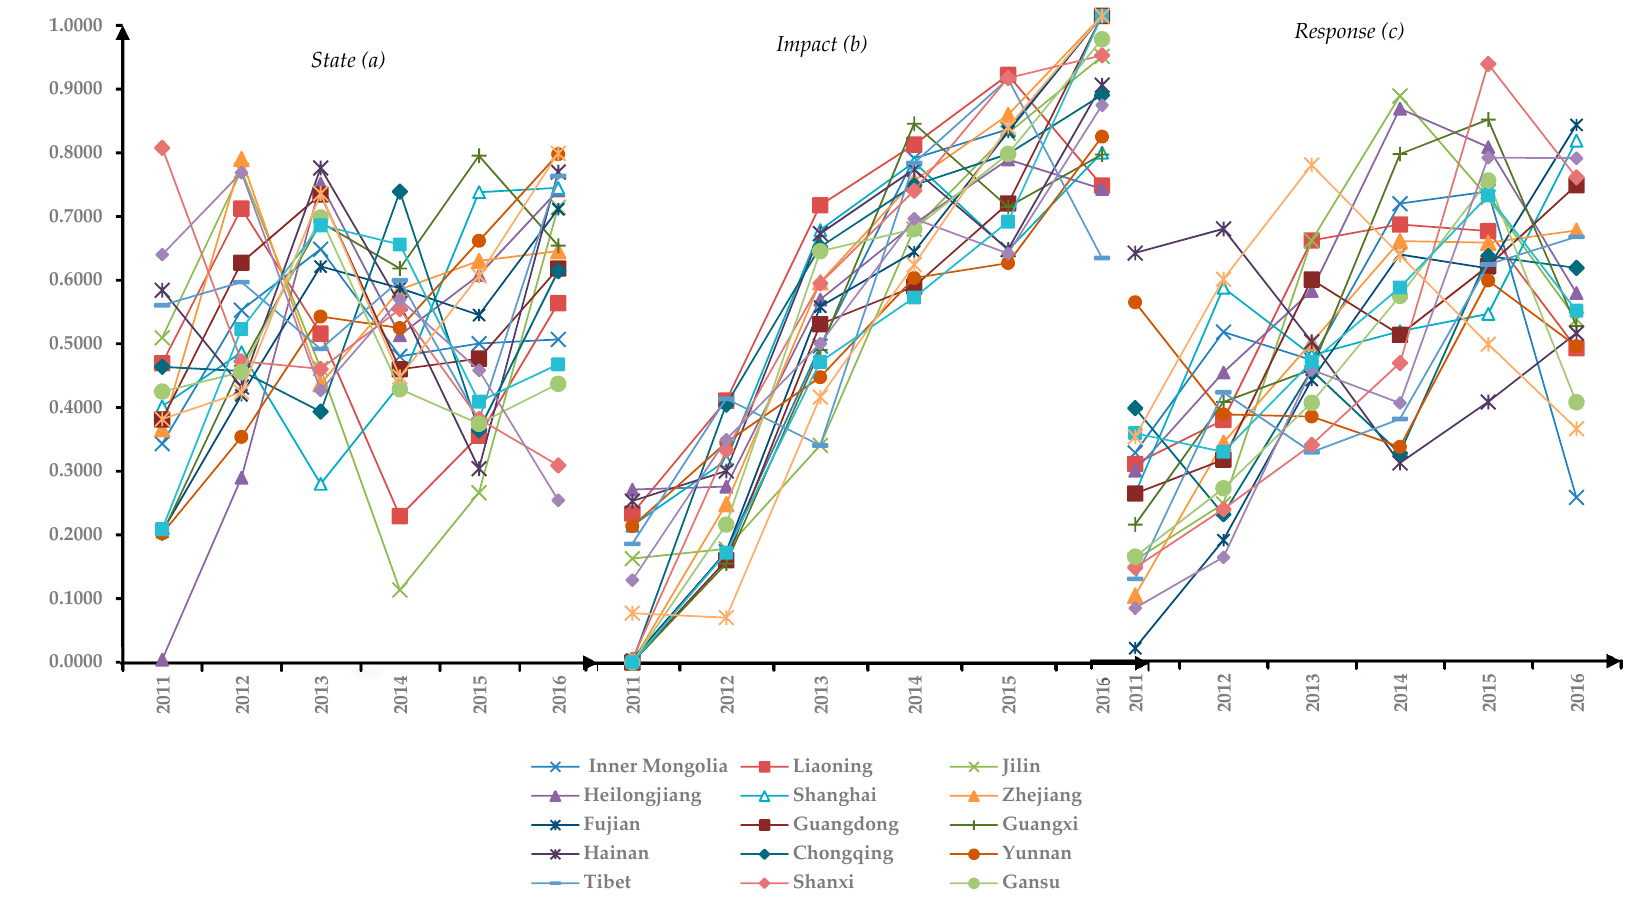
Figure 6. State ( a ), Impact ( b ), and Response ( c ) subsystems in the One Belt and One Road Area of Figure 6. State (d), Impact (e), and Response (f) subsystems in the One Belt and One Road Area of China.